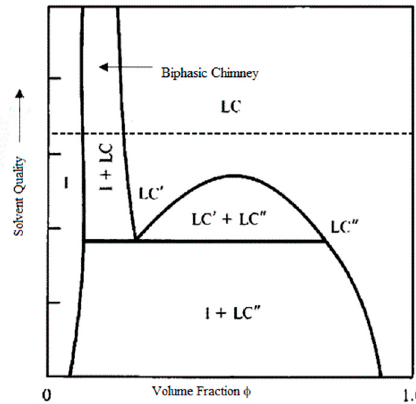
Figure 4. Generic phase diagram showing the biphasic chimney for favorable solvents, a broad coexistence region for less favorable solvents, and the potential for coexistence of multiple liquid